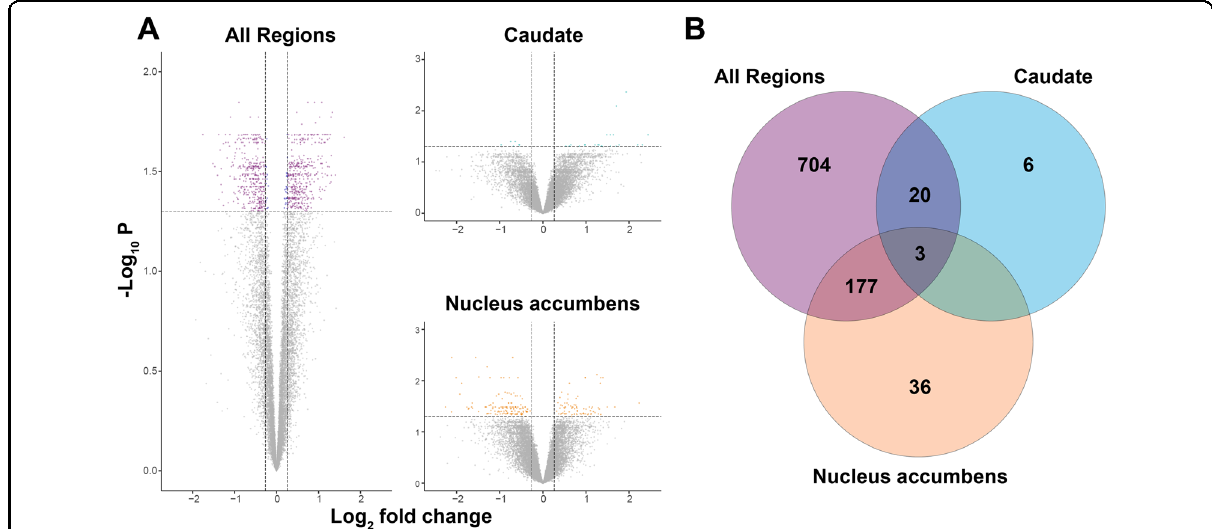
Fig. 1 Volcano plots of differentially expressed genes between obsessive-compulsive disorder (OCD) subjects and unaffected comparison subjects. RNA sequencing was performed on post-mortem brain tissue originating from Brodmann areas 11 and 47 (OFC), the caudate, and the nucleus accumbens of 7 OCD subjects and 8 unaffected comparison subjects. A Left panel: differentially expressed genes were determined for all brain regions analyzed together. Upper right panel: differentially expressed genes in caudate. Lower right panel: differentially expressed genes in nucleus accumbens. The y -axis represents the ( − log 10 P -value) and the x-axis represents the gene expression log 2 fold change. Vertical dashed lines (±0.26 log 2 fold change) indicate gene expression differences between OCD subject and unaffected comparison subject cohorts, where upregulated genes are positive and downregulated genes are negative. The horizontal line demarcates signi fi cantly different gene expression differences between OCD subjects and unaffected comparison subjects (false discovery rate q -value <0.05; purple ( ≥ 0.26 or ≤ − 0.26 log 2 fold change)/blue ( ≤ 0.26 and ≥ − 0.26 log 2 fold change) dots = signi fi cant, gray dots = non-signi fi cant). Note: the volcano plot for the cortical regions (Brodmann areas 11 and 47) is shown in Fig. S3. B Venn diagram depicting the overlapping differentially expressed genes between all brain regions (purple), caudate (cyan), and nucleus accumbens (orange). There were no overlapping differentially expressed genes at the intersection between caudate and nucleus